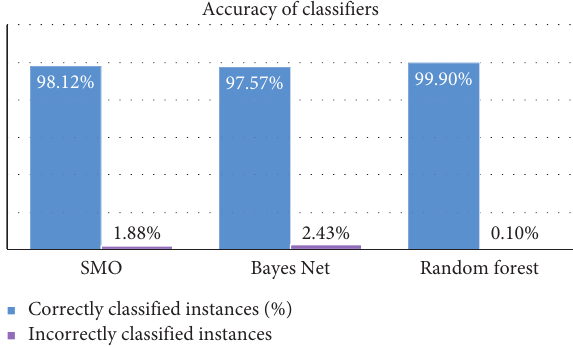
Figure 2: Classification accuracy of